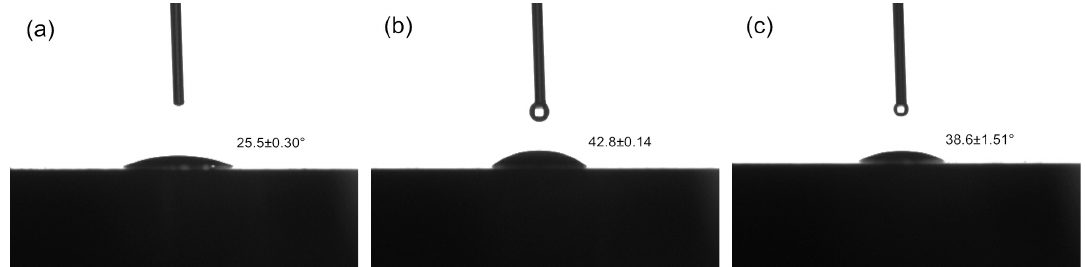
Figure 2. The contact angle images of a water sessile drop on the pressed pellet of ( a ) bastnaesite, ( b ) bastnaesite treated with SHA, ( c ) bastnaesite treated with strontium ions and SHA. (pH = 8, strontium ions: 1 × 10 − 4 mol/dm 3 , SHA: 5 × 10 − 4 mol/dm 3 ).